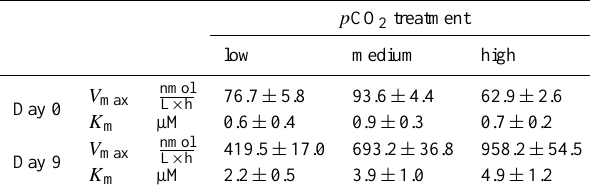
Table 1. Phosphatase activity characteristics: V max is the maximum rate achieved by the system at saturating substrate concentrations in nmol per litre and hour; the Michaelis–Menten constant K m is the substrate concentration inµM at which the reaction rate is half of V max . R 2 > 0 . 97; substrate concentrations ranged from 1–150µM; number of substrate concentrations used for each regression=7.